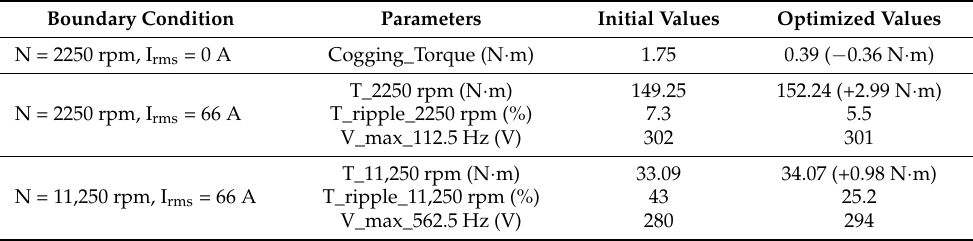
Table 7. Output parameters after optimization.